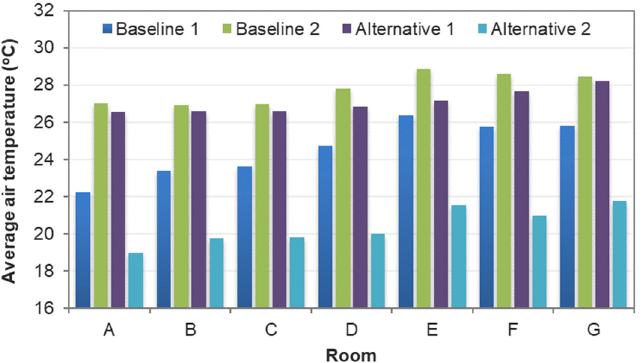
Figure 12. Comparison of average indoor temperature between different rooms.